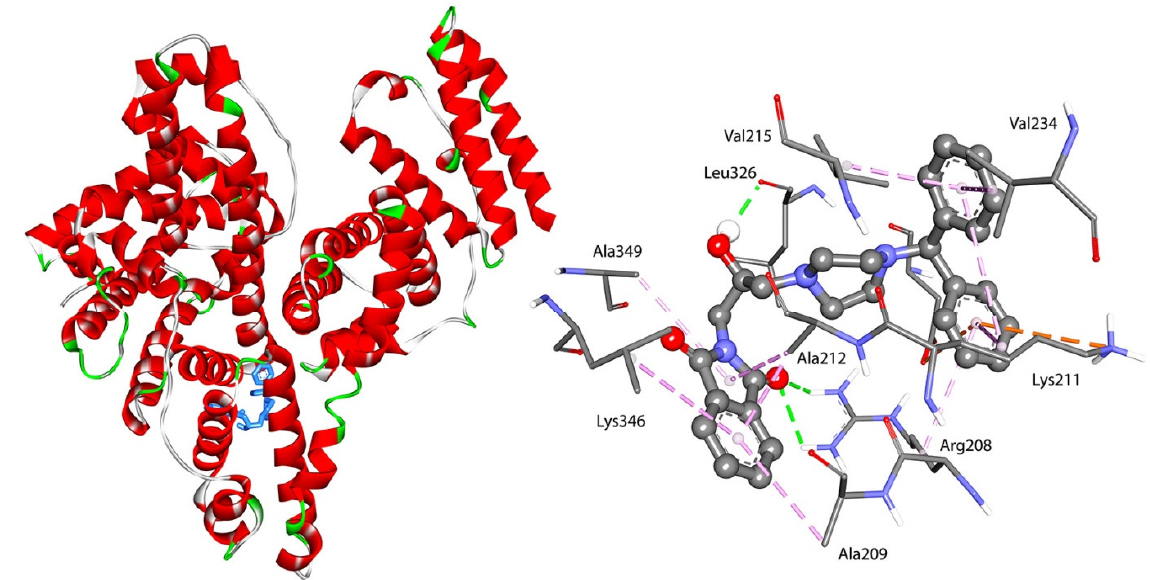
Figure 7. Docked pose and interactions of compound F4 with BSA in site II.